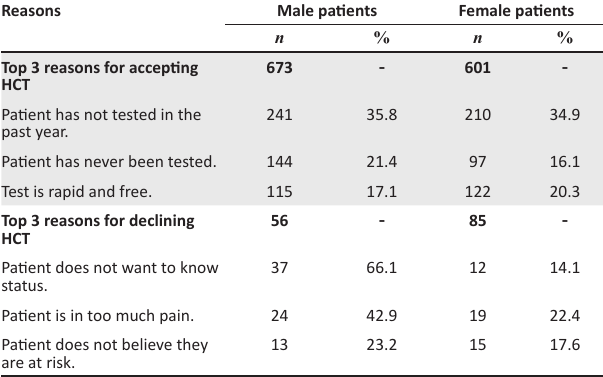
TABLE 3: Reasons for accepting or declining HIV counselling and testing by gender. Reasons Male patients Female